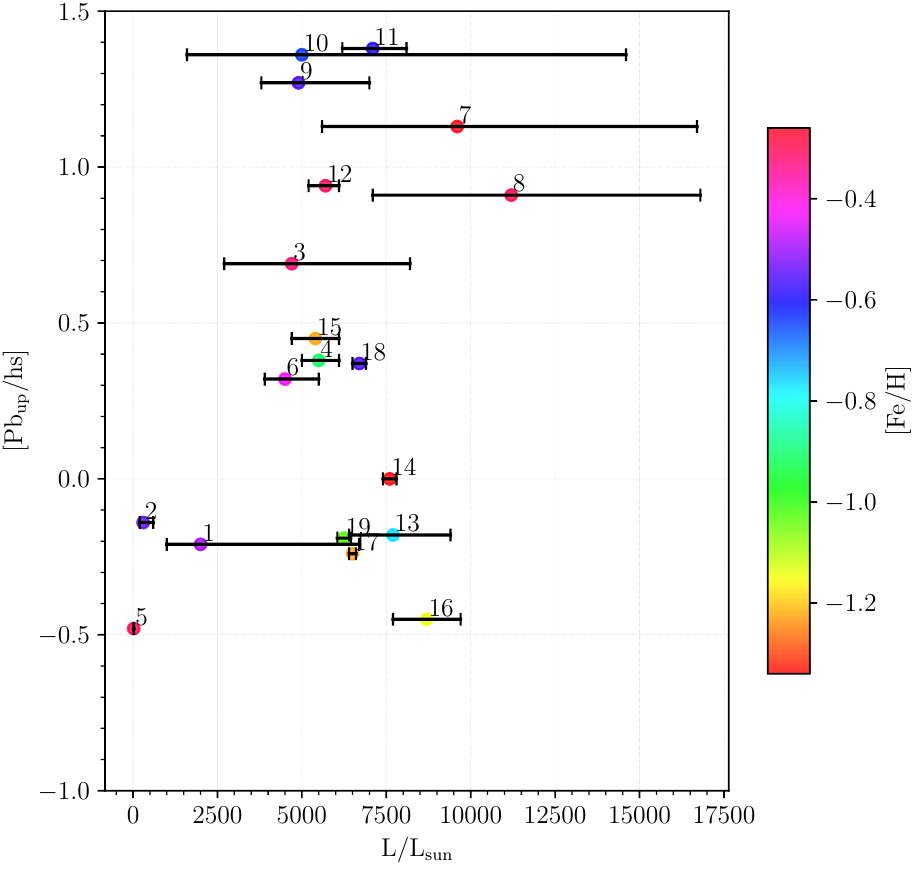
Figure 1. [Pb up /hs] as a function of derived photospheric luminosities for the sample of post-AGB stars considered in this study. The color bar represents the metallicity ([Fe/H]) of the objects. See Section 3 for more